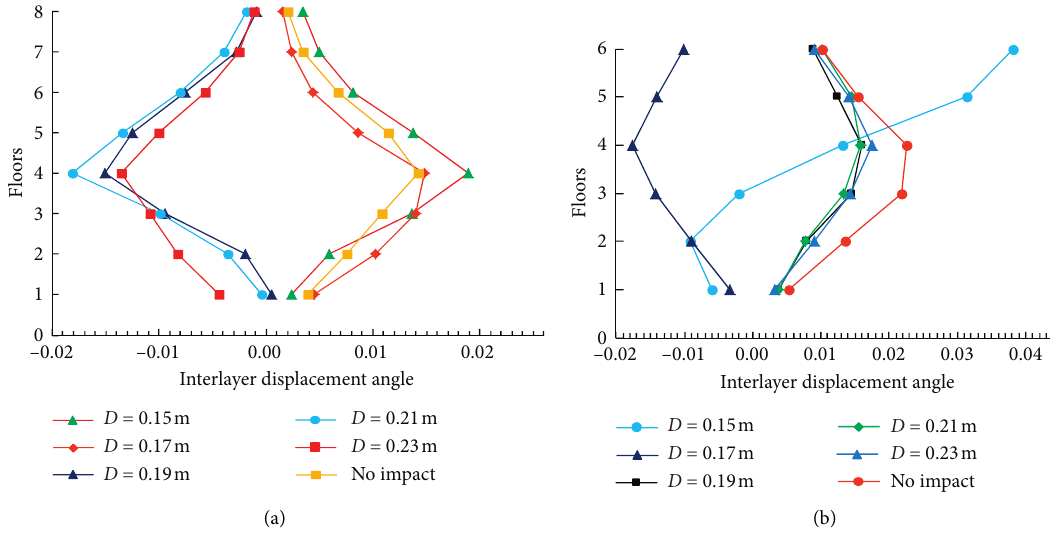
Figure 13: Variation curve of interlayer displacement angle under different gap sizes (PGA � 0.40g): (a) KJ-A and (b) KJ-B.